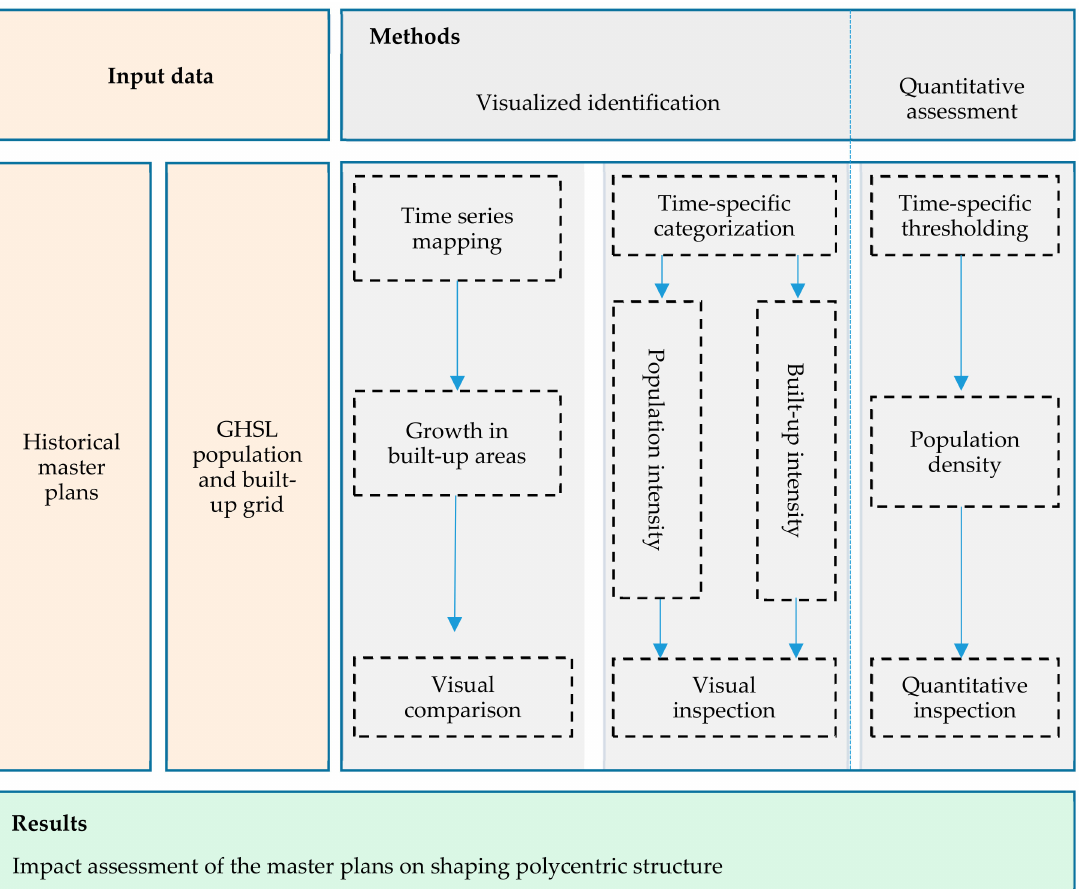
Figure 2. Conceptual framework of impact assessment: input data, methods and respective workflow.